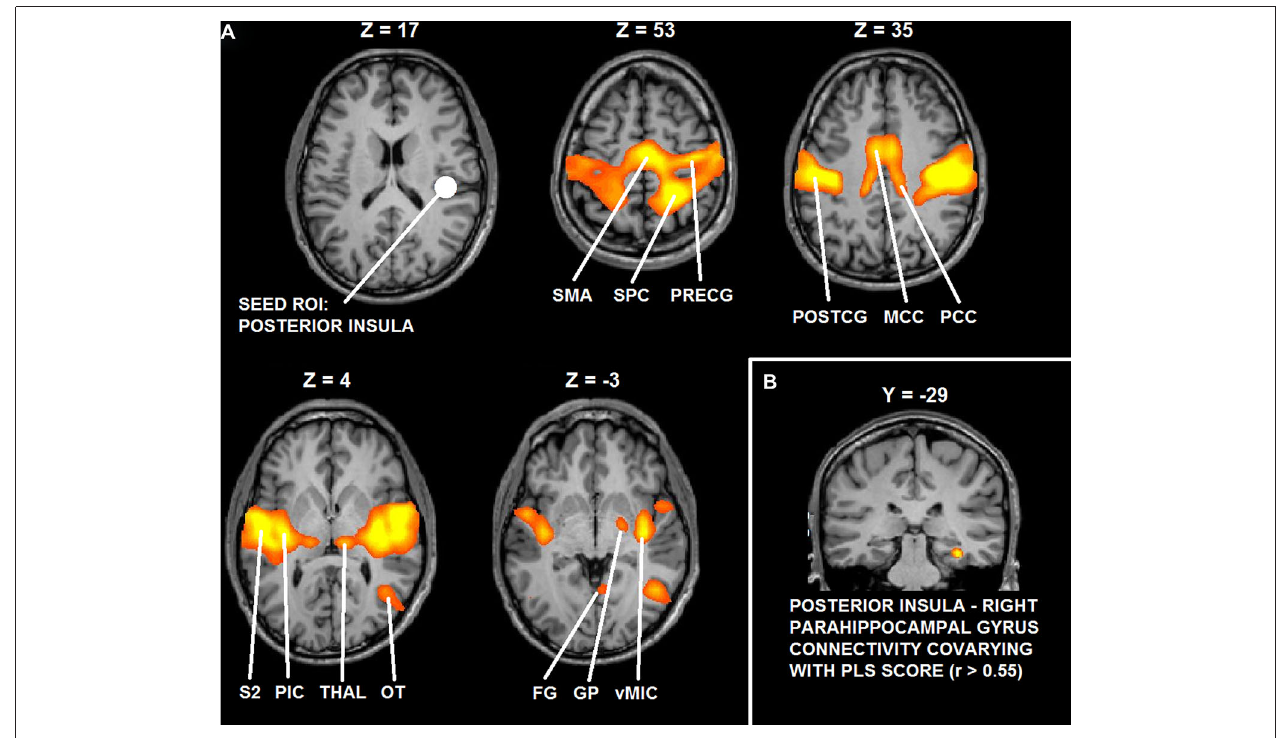
precentral gyrus; PostCG: postcentral gyrus; MCC: mid cingulate cortex; PCC: posterior cingulate cortex; S2: secondary somatosensory cortex; pIC: posterior insula; Thal: thalamus; OT: occipital-temporal cortex; FG: fusiform gyrus; GP: globus pallidus; vMIC: ventral mid insular cortex.